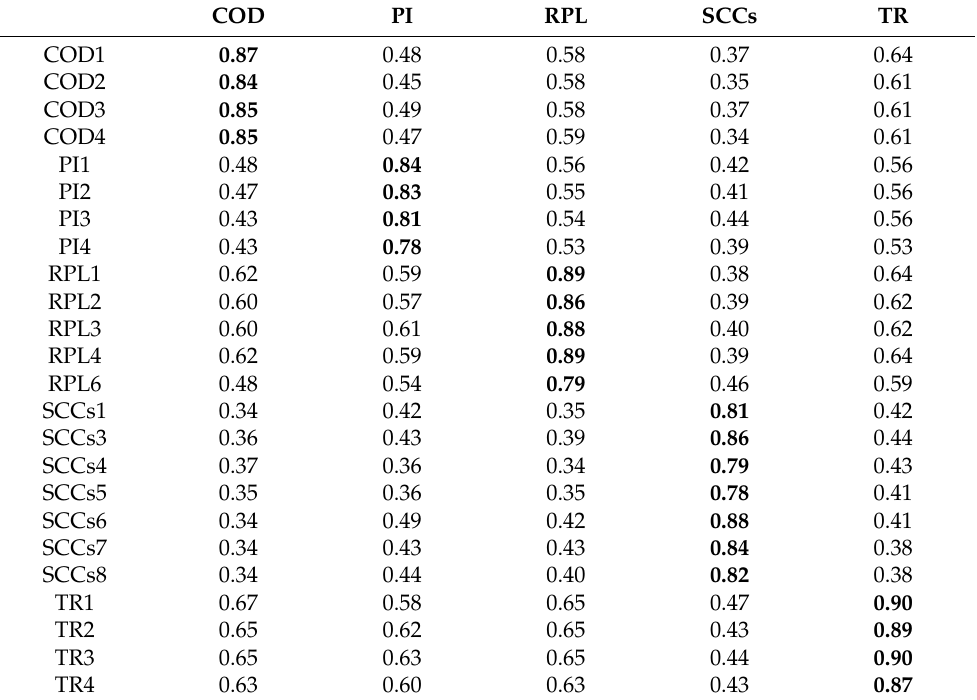
Table 4. Cross loadings.